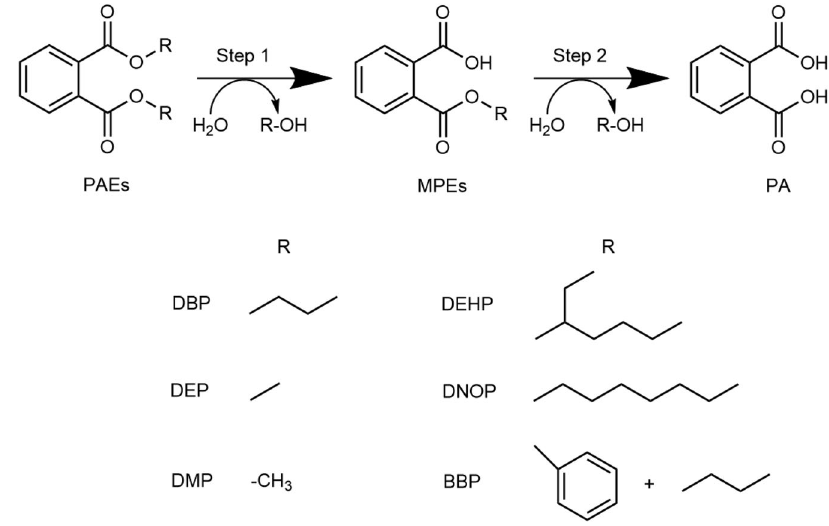
Fig. 1 Degradation steps of PAEs by PAE hydrolases. The aliphatic chains of several widely used PAEs are